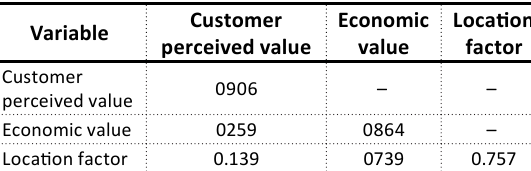
Table 15. Fornell-Larcker criterion